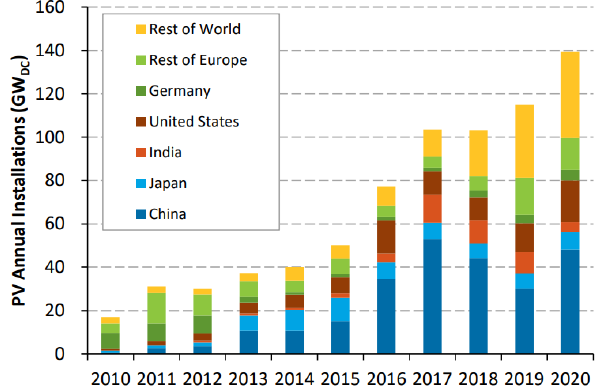
Figure 1. PV annual installations from 2010 to 2020 [90,91].